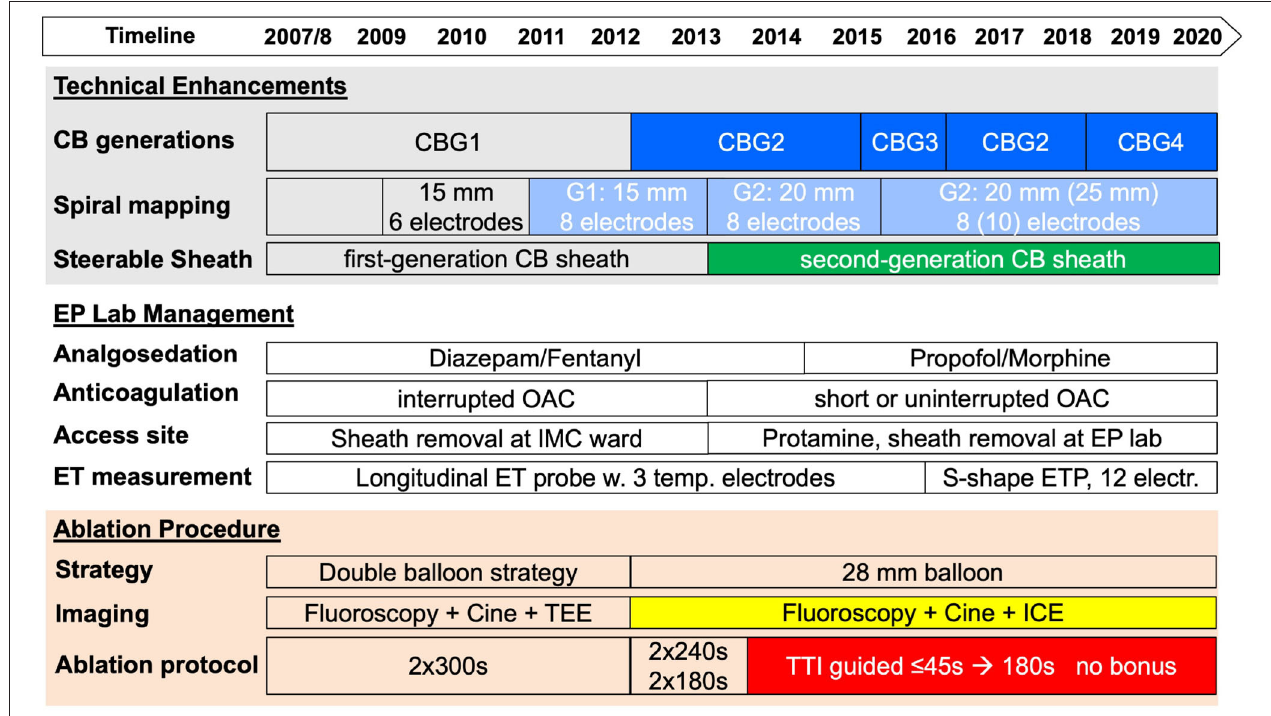
FIGURE 1 | Evolution of cryoballoon ablation for persistent atrial fibrillation (AF) from 2007 to 2020. A timeline of technical enhancements, improvement in laboratory management, and implementation of new cryoballoon protocols are shown in the upper part of the figure. CB, cryoballoon; CBG, cryoballoon generation; EP, electrophysiology; ET, esophageal temperature; ICE, intracardiac echocardiography; TEE, transesophageal echocardiography; TTI, time-to-isolation.